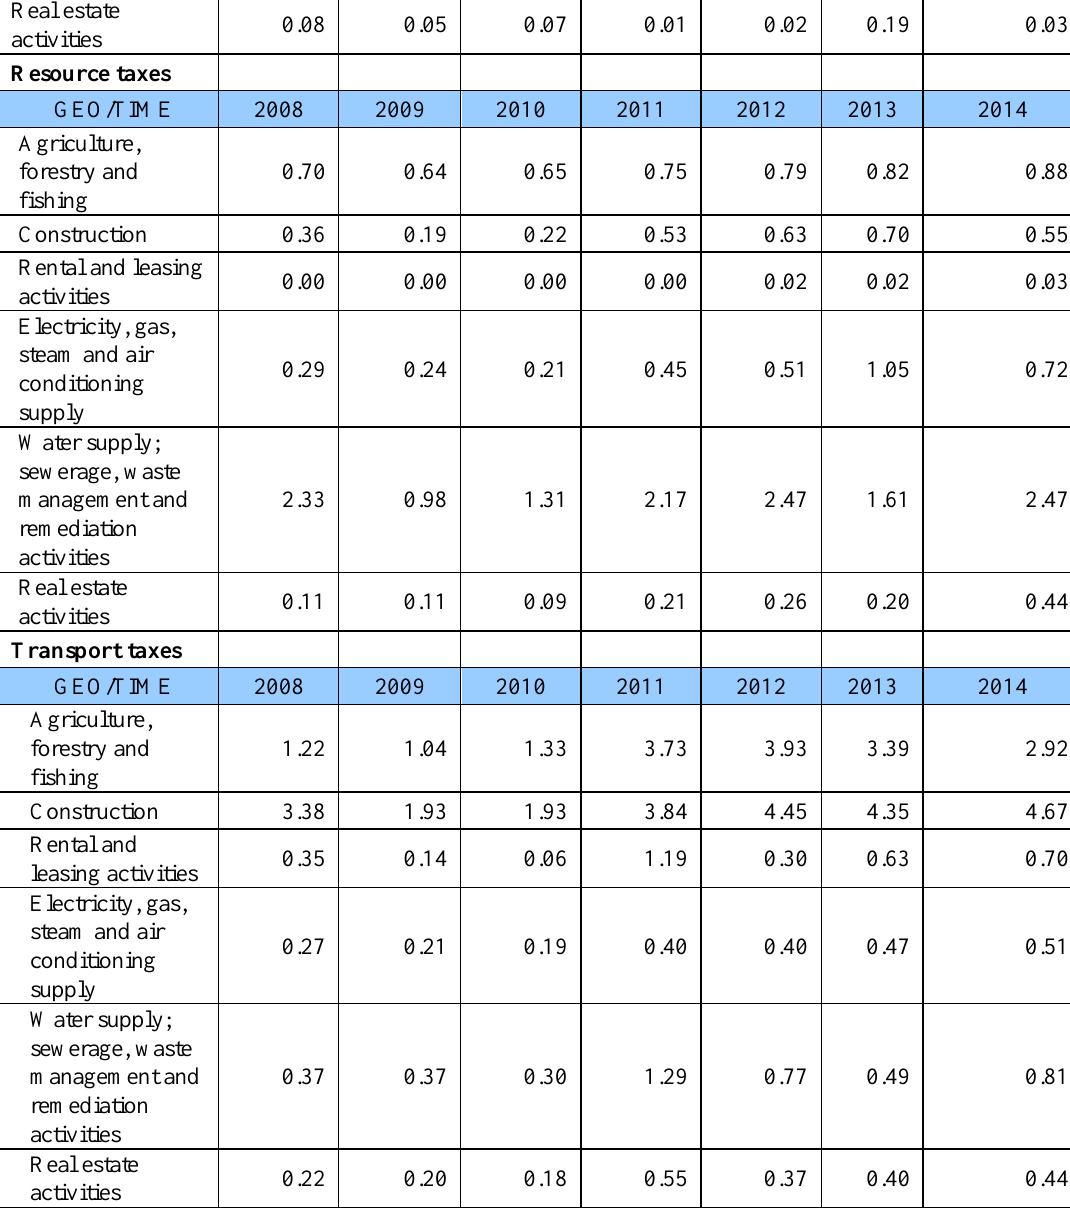
Table 5. Environmental tax revenues in the Baltic States, total, M Euro. Data: Eurostat (n. d.) (last available data on October 17, 2017) [developed by